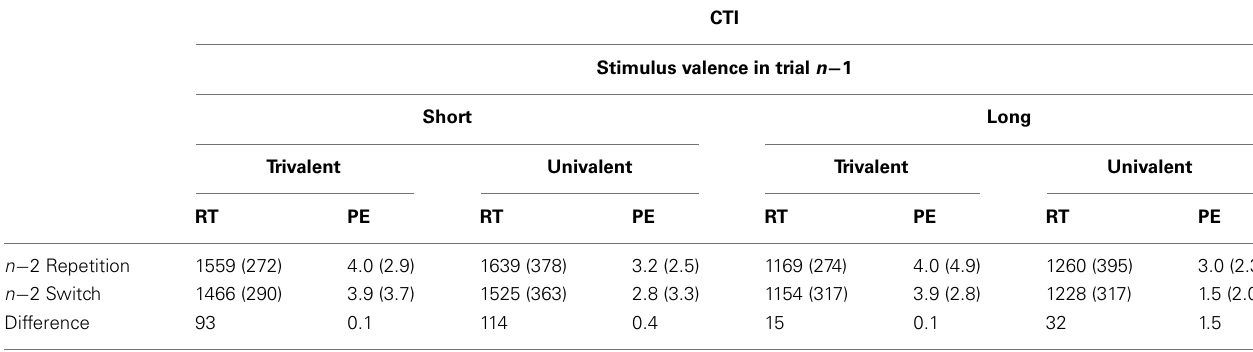
Table 2 | RT (SD) and PE (SD) in Experiment 2 for trivalent stimuli in trial n as a function of task sequence ( n − 2 repetition vs. n − 2 switch), stimulus valence in trial n − 1 (trivalent vs. univalent), and cue-target interval (short vs.